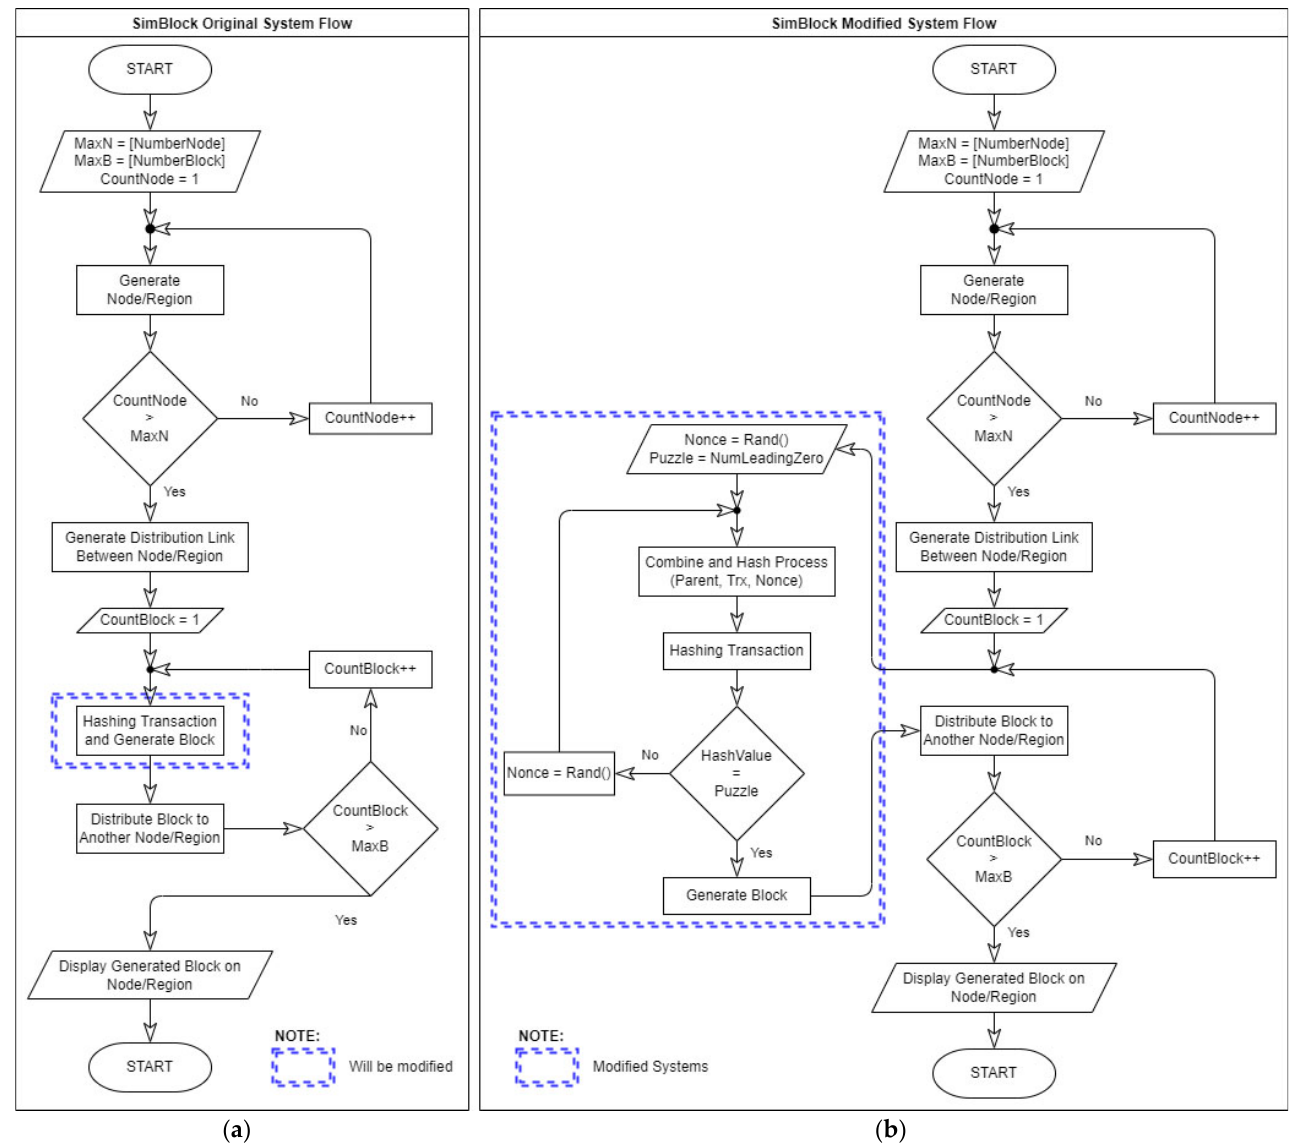
Figure 5. SimBlock simulator system flow ( a ) Original system; ( b ) modified system.